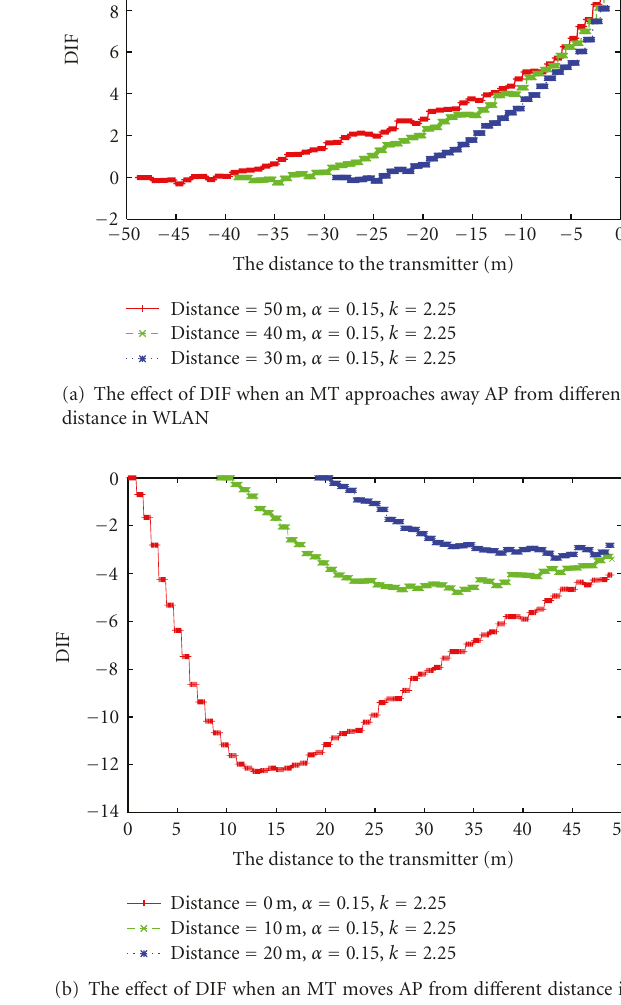
Figure 14: MT approaching and moving away AP from various